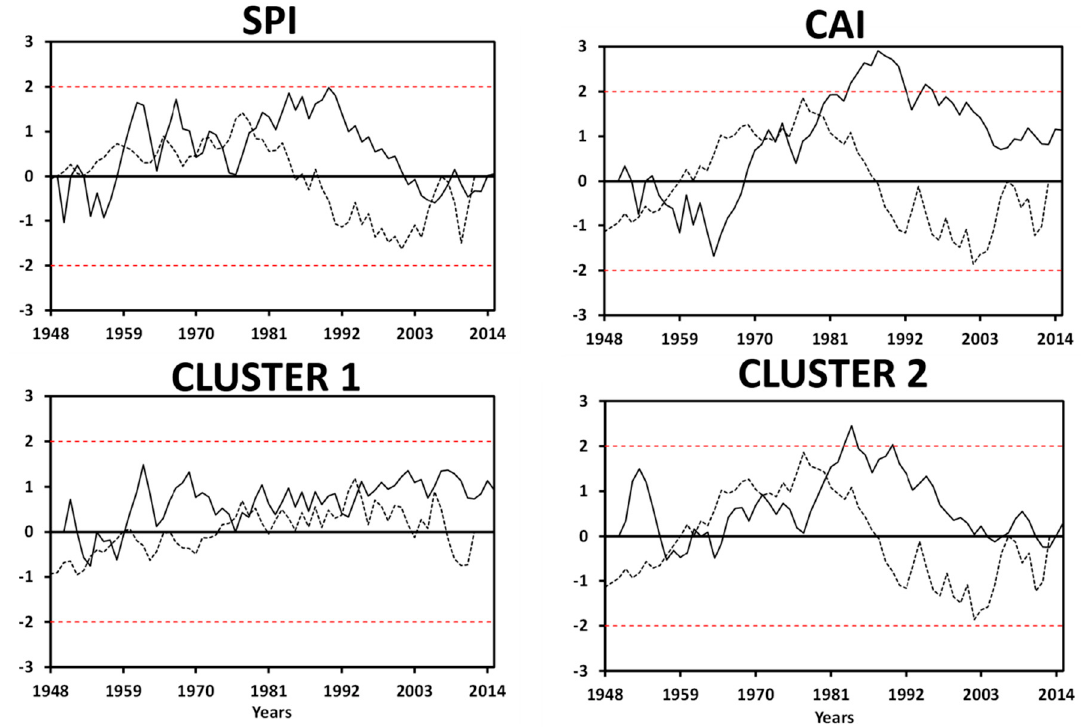
Figure 7. Values of progressive (u(t), solid line) and retrograde (u’(t), dashed line) values of the sequential Mann-Kendall test, corresponding to the long-term (1948–2015) evolution of wave storminess and the associated atmospheric indices. Horizontal (red) dashed lines correspond to confidence limits at the 5% significance level.